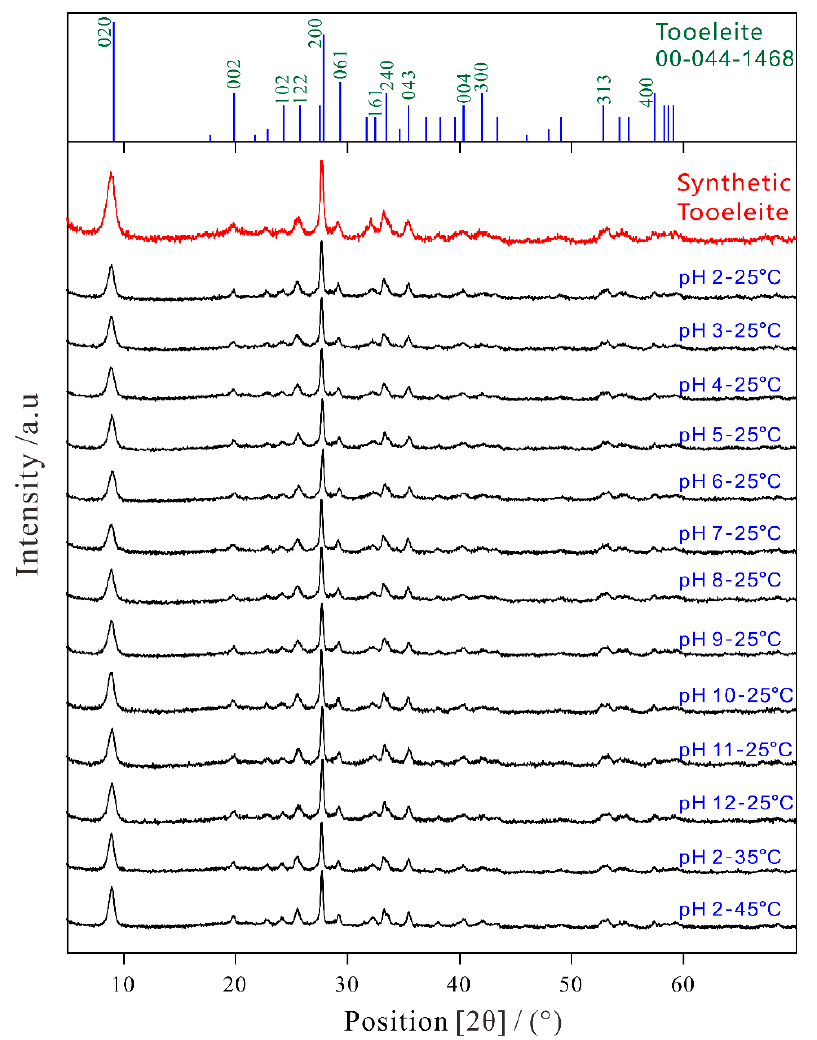
Figure 1. XRD spectra of the synthetic tooeleite before and after dissolution for 330 d.